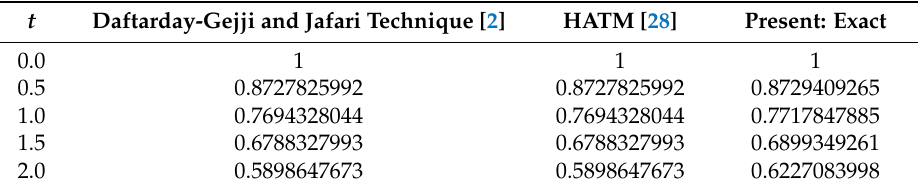
Table 1. Comparison of the present exact solution with the homotopy analysis transform method (HATM) and Daftarday-Gejji and Jafari solutions. t Daftarday-Gejji and Jafari Technique [2] HATM [28] Present: Exact